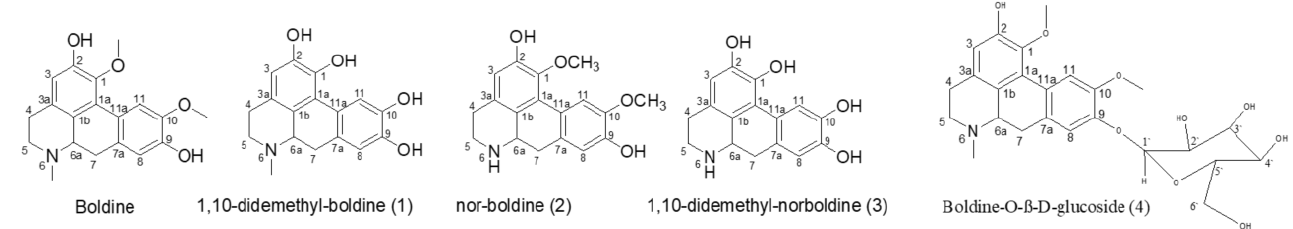
Figure 1. Structure of boldine and its metabolites. The 1 H NMR data of boldine metabolite- 2 (Table 1, SI: Figure S7) displayed the lack